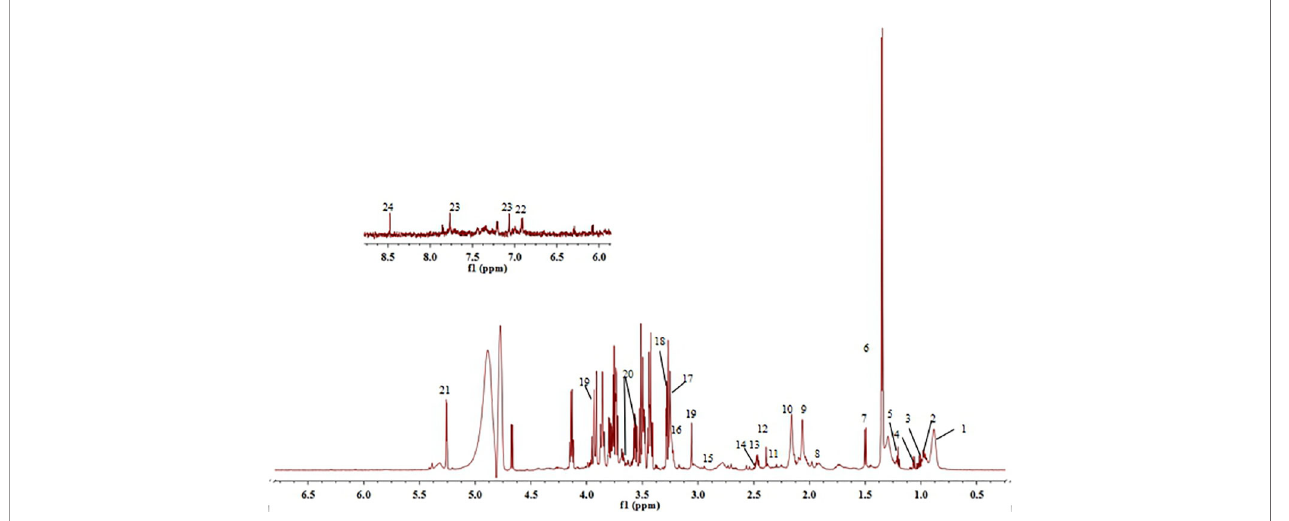
FIGURE 7 | 1 H-NMR spectra of serum obtained from control group. (1) Lipid, (2) Leucine, (3) Valine, (4) Isoleucine, (5) b -hydroxybuty acid, (6) Lactic acid, (7) Alanine, (8) Acetate, (9) N-acetylglycoprotein, (10) O-acetylglycoprotein, (11) Acetoacetate, (12) Glutamic acid, (13) Pyruvate, (14) Glutamine, (15) Dimethylamine, (16) Choline, (17) Phosphatidylcholine, (18) Trimethylamine oxide, (19) Creatine, (20) Glycerin, (21) a -Glucose, (22) Tyrosine, (23) Histidine, and (24)